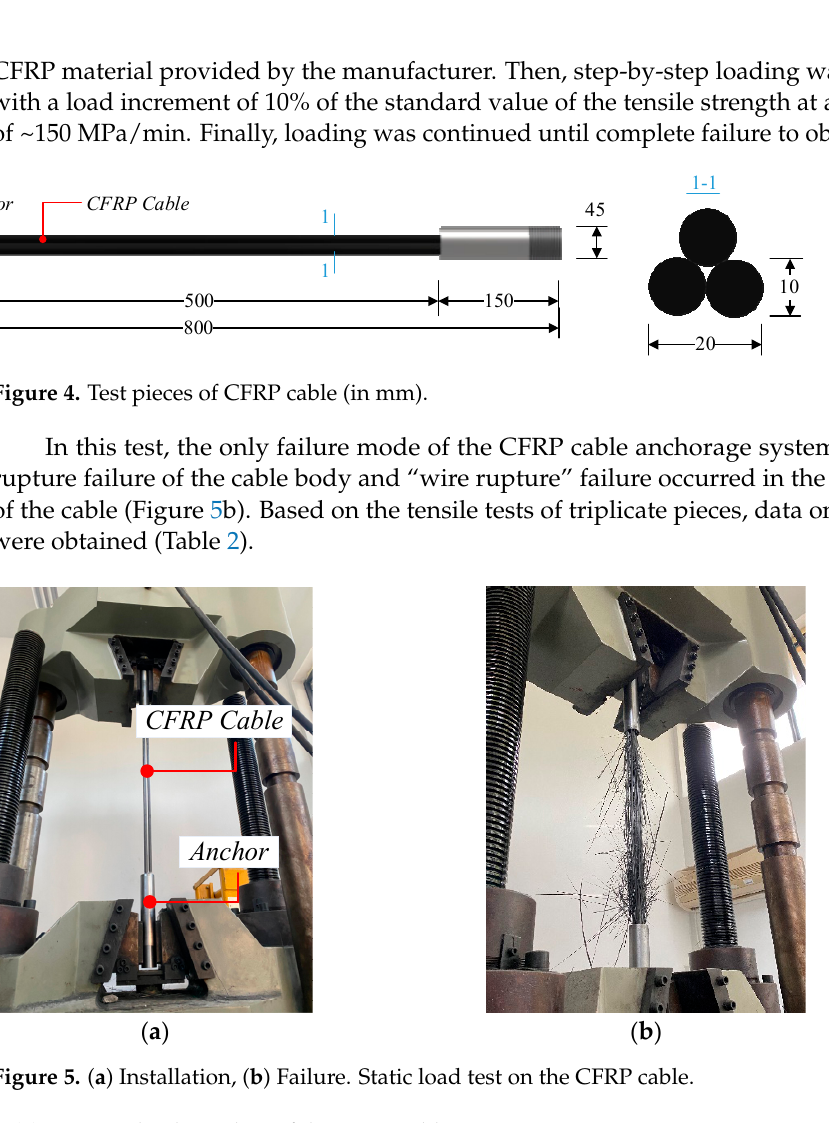
Figure 4. Test pieces of CFRP cable (in mm).